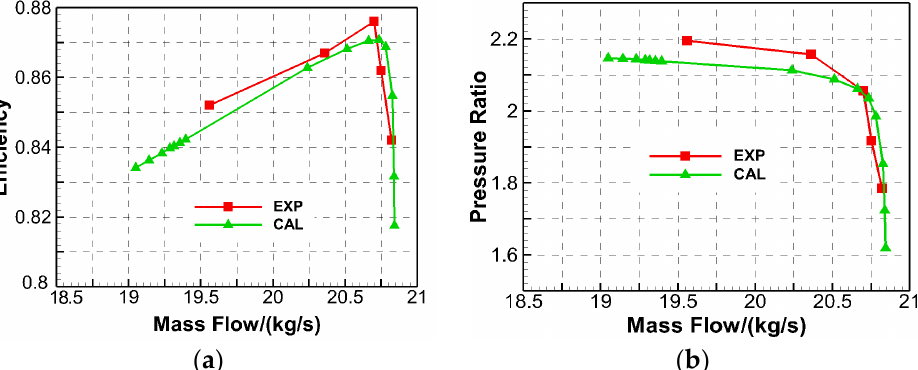
Figure 1. The comparison of the numerical simulation and the experimental results of rotor37. ( a ) the isentropic efficiency. ( b ) the total pressure ratio.